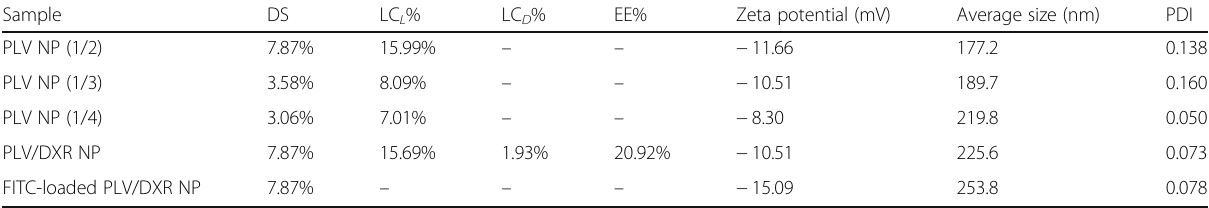
Table 3 Characterizations of PLV nanoparticles